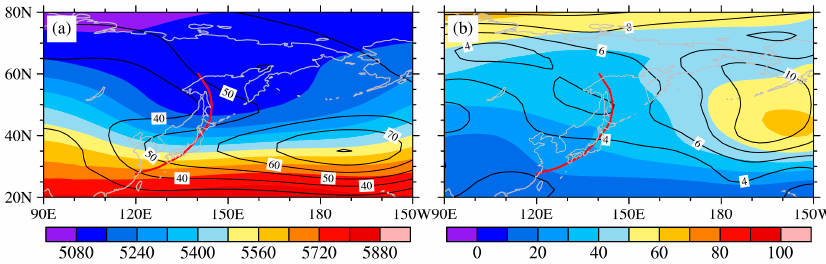
Figure 5. ( a ) Climatological mean of the geopotential height at 500 hPa in the MME (colors, gpm) and their intermodel spreads (contours, shown as the standard deviation among 12 CMIP5 models); ( b ) as in ( a ), but for the interannual standard deviation in the boreal winter. Red line represents the EAT trough line in MME.